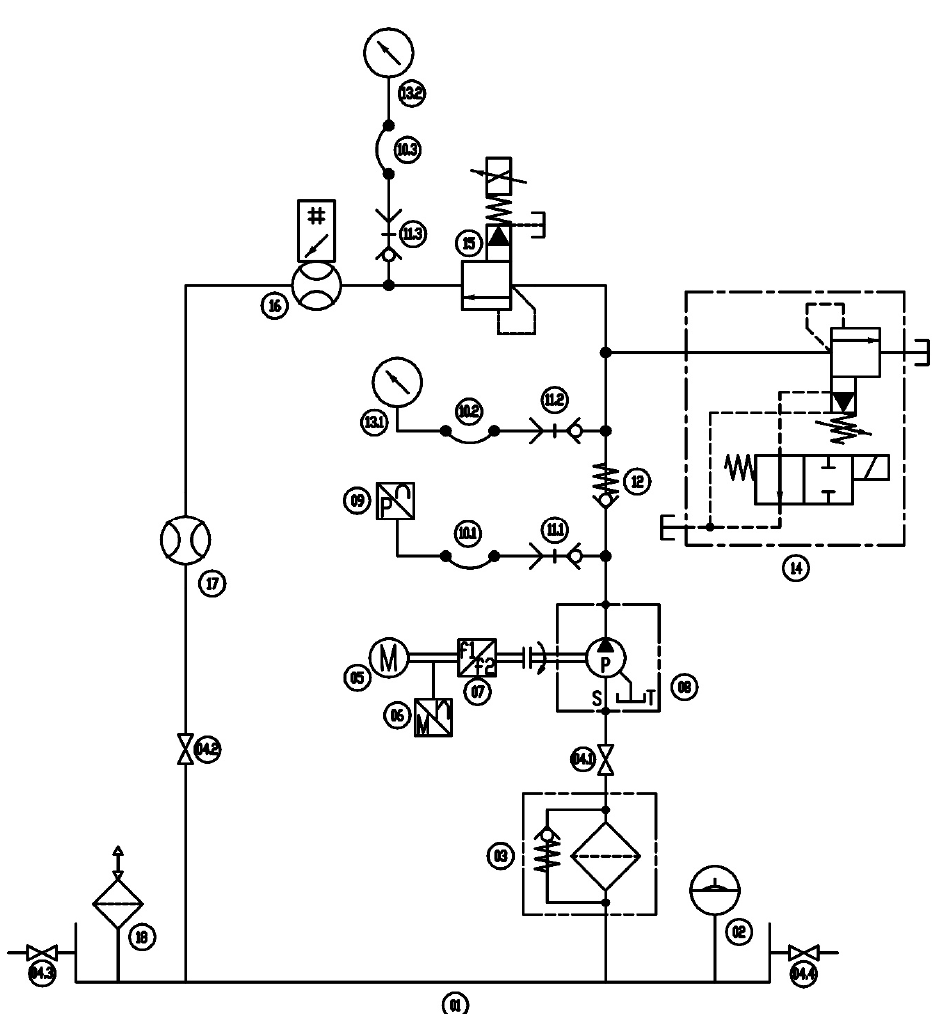
Figure 17. Design schematic diagram of hydraulic system: 01–tank; 02–level gauge; 03–suction filter; 04–shut–off valve; 05–variable frequency motor; 06–torque speed sensor; 07–frequency converter; 08–test pump; 09–pressure sensor; 10–pressure measuring hose; 11–pressure measuring connector; 12–check valve; 13–pressure gauge; 14–electromagnetic spill valve; 15–proportional relief valve; 16–digital flow meter; 17–flow meter; 18–air filter.